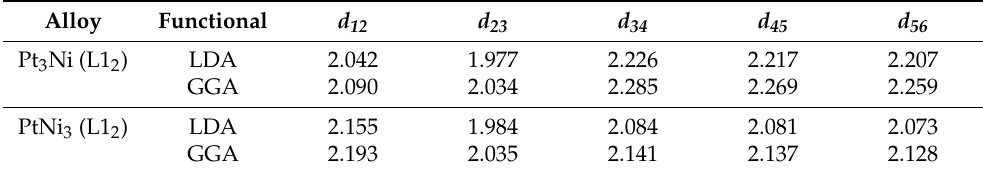
Table 4. The interlayer spacing d 12 , d 23 , d 34 , d 45 and d 56 defined in Figure 12 of the unreacted (111)-Pt/Ni/Pt 3 Ni and (111)-Pt/Ni/PtNi 3 surfaces. The ‘Functional’ column shows the exchange-correlation functional used (LDA/GGA). All lengths are given in units of Å.